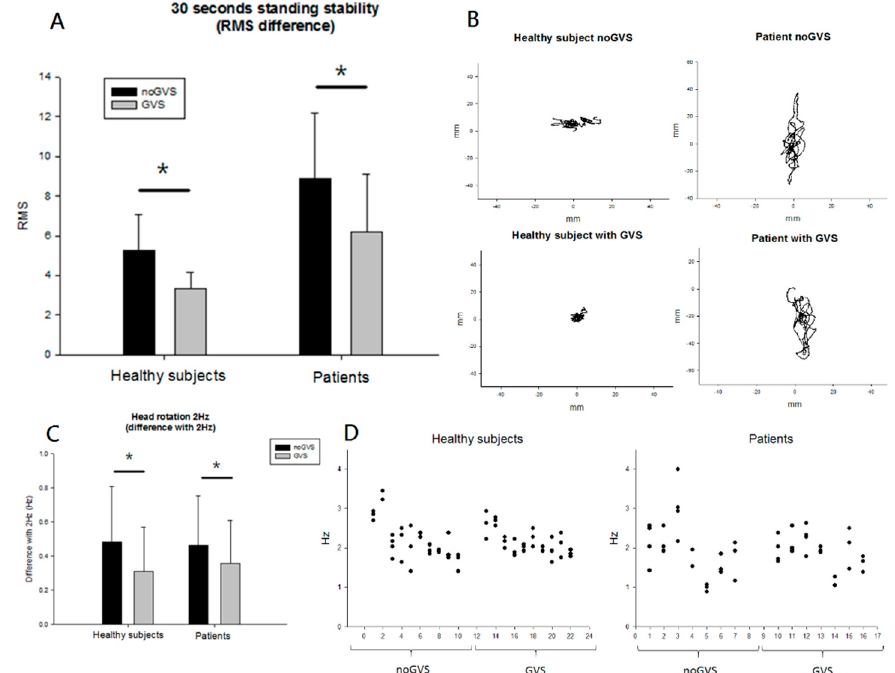
Figure 2. Behavioral results of subjects with and without noisy galvanic vestibular stimulation (GVS) during walking and standing conditions. ( A ) Shows the center of pressure (COP) displacements mean root mean square (RMS) in healthy and patient groups. In healthy group, the mean RMS was 5.27 ± 1.79 without noisy GVS and 3.36 ± 0.80 with noisy GVS in standing condition ( p = 0.005, Wilcoxon signed rank test). In patient group, the mean RMS was 8.86 ± 3.31 without noisy GVS and 6.19 ± 2.29 with noisy GVS ( p = 0.018, Wilcoxon signed rank test). ( B ) Displays the COP displacements in one single healthy & one patient subjects. When walking with 2 Hz head yaw, both healthy and patient groups showed a tendency towards a closer proximity to 2 Hz head yaw with noisy GVS. (Healthy subjects with GVS = 0.48 ± 0.32 Hz; without GVS = 0.31, ± 0.26 Hz, p = 0.005. In patients, with GVS = 0.46, ± 0.28 Hz; without GVS = 0.35, ± 0.24 Hz, p = 0.018, ( C ). The head turning frequency for each subject with and without noisy GVS is shown in scattered plot ( D ). * no GVS: the condition without noisy GVS stimulation. * GVS: the condition with noisy GVS.